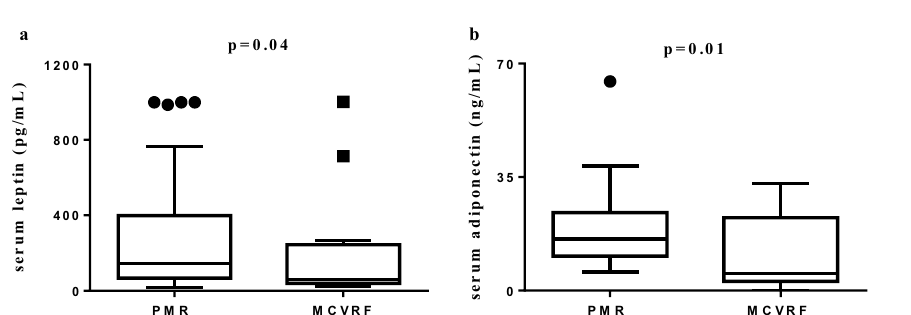
Figure 4. Correlation between IMT and CAVI values (right/left side mean values). ( a ) Patients with 2 polymyalgia rheumatica (n = 48) ( r = 0.845; p < 0.01). ( b ) Major cardiovascular risk factors controls (n = 56) ( r 0.556; p < 0.01). CAVI cardio-ankle vascular index, IMT intima-media thickness.